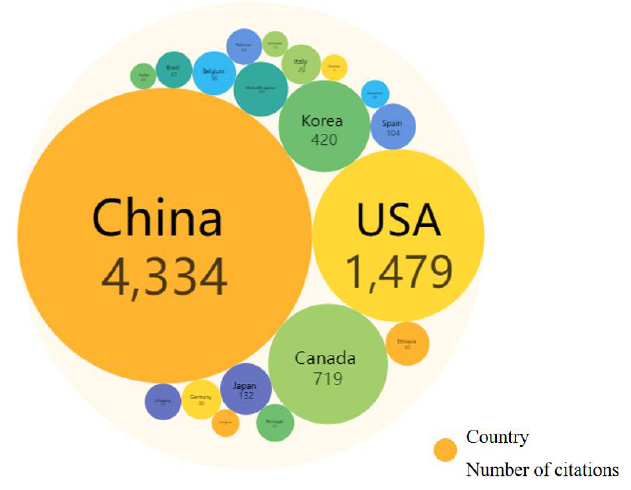
Figure 7. Citation times of papers in some countries in the field of rural revitalization.